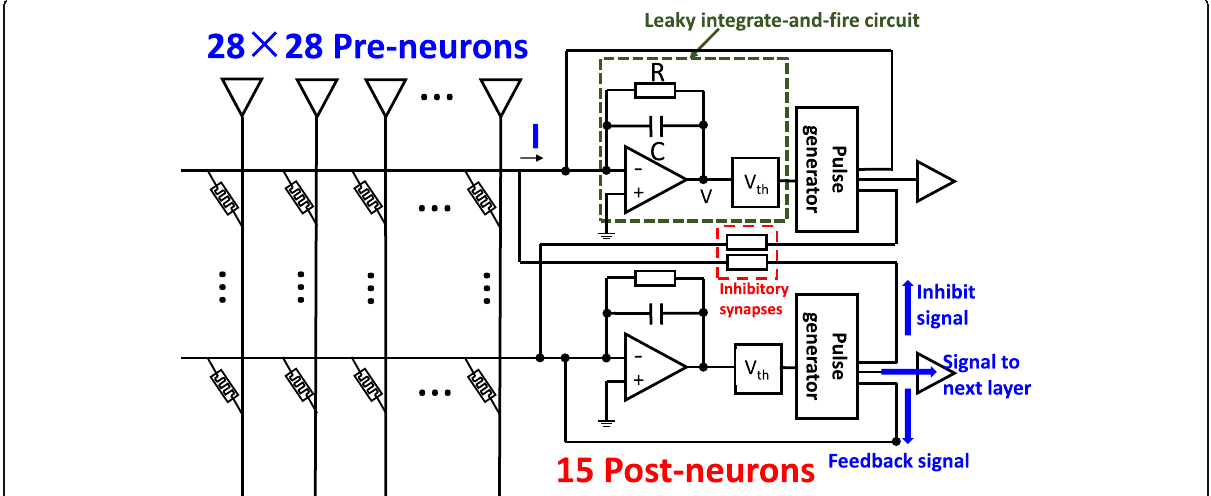
Fig. 5 Schematic of an unsupervised online learning system. RRAM cells work as the synapses. Leaky integrate-and-fire circuits and pulse generators construct the post-neurons. Crossbar structure enables pre- and post-neurons fully connected. Fired post-neuron generates three signals: feedback signal, inhibit signal, and signal to next layer